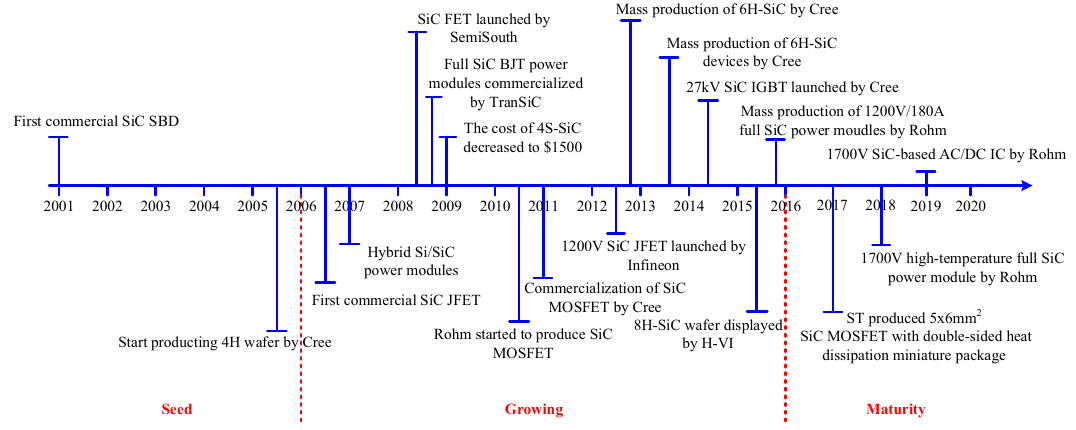
Figure 1. The milestones of the development process of SiC power electronic devices